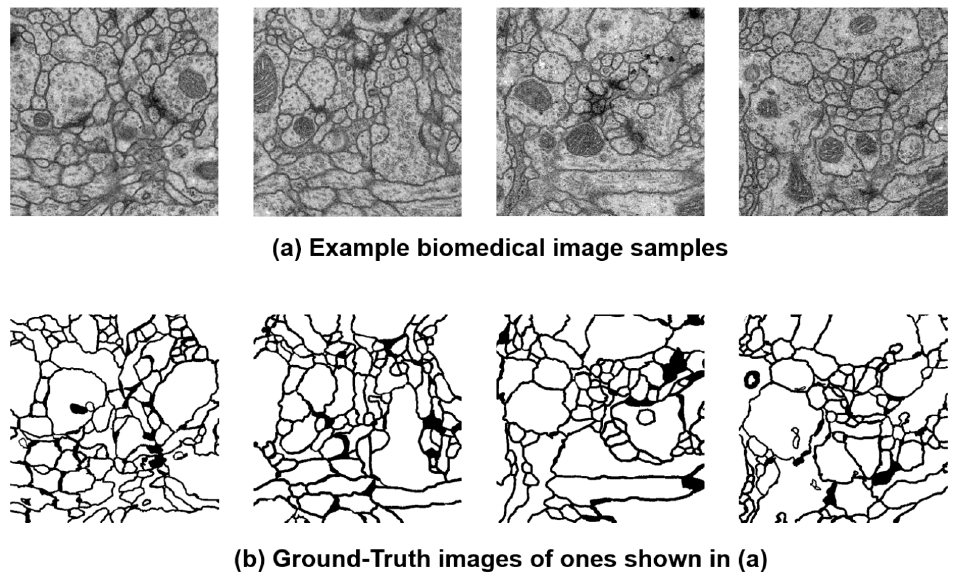
Figure 31. The example benchmark images involved in ssTEM dataset. ( a ) describes several sample training images and ( b ) illustrates their GT ones.